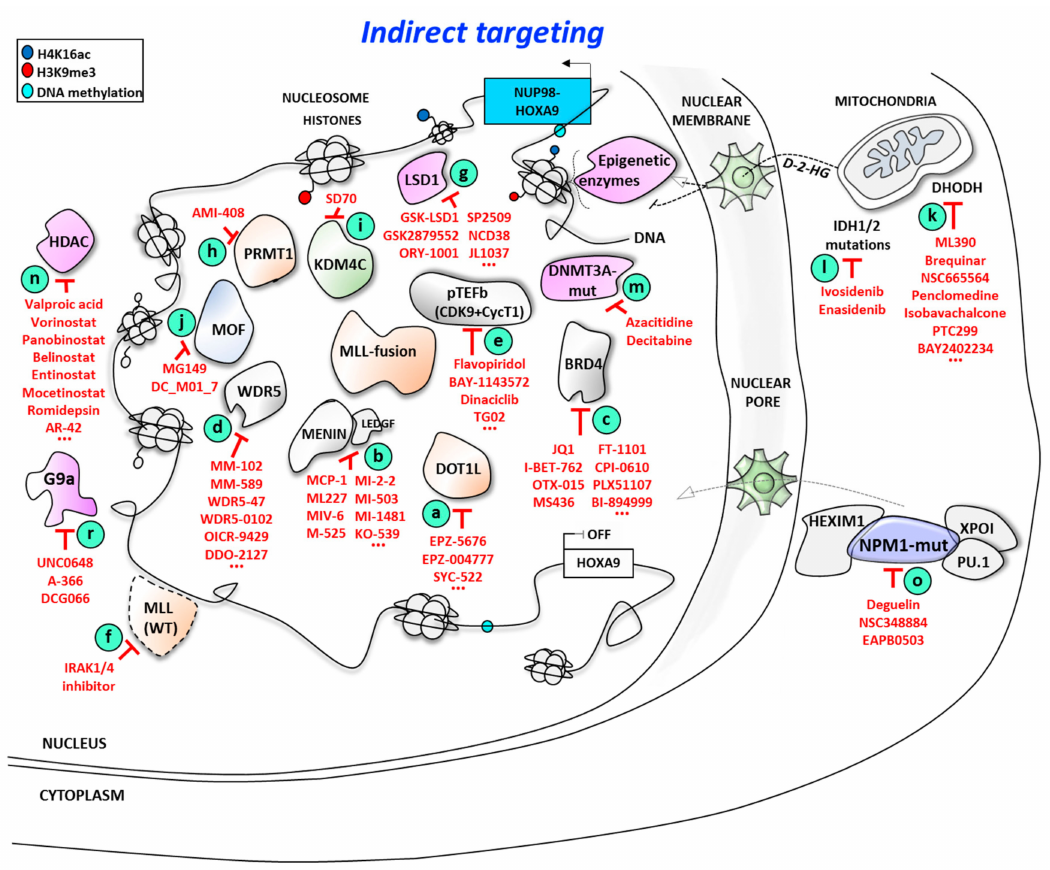
Figure 2. Indirect targeting of HOXA9 expression in AML: multiple epigenetic and non-epigenetic therapeutic